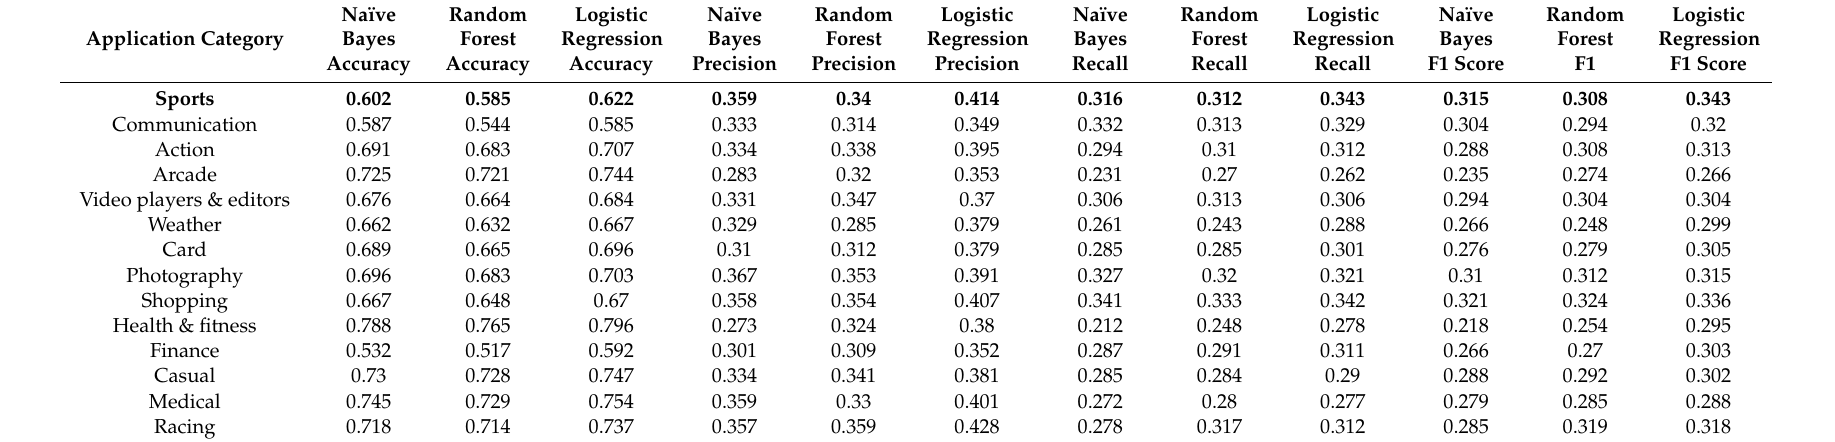
Table 2. Di ff erent machine-learning algorithm comparison of TF-based data after preprocessing.